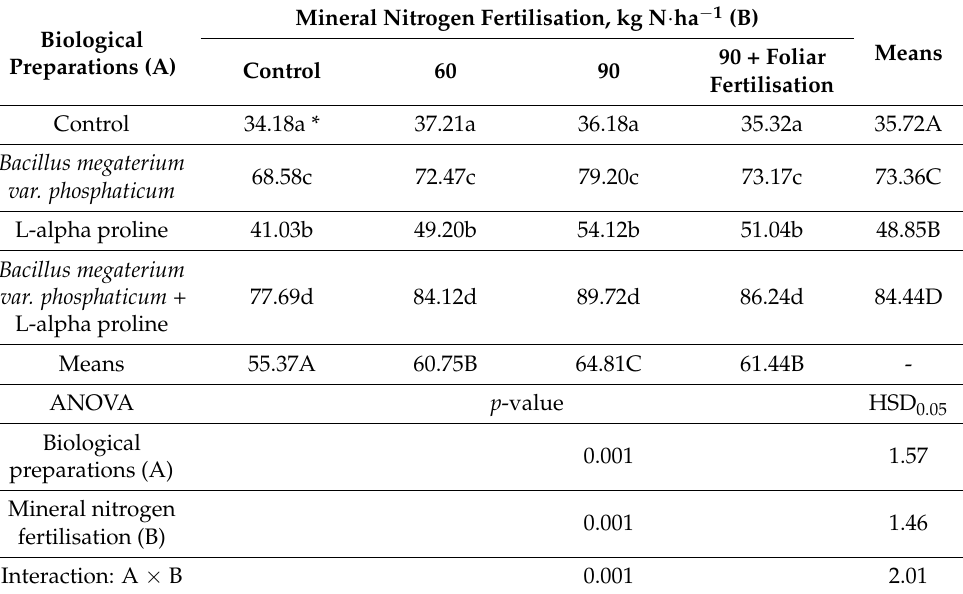
Table 5. Fe content in spring wheat grain (means across 2017–2019), mg · kg − 1 d.m.